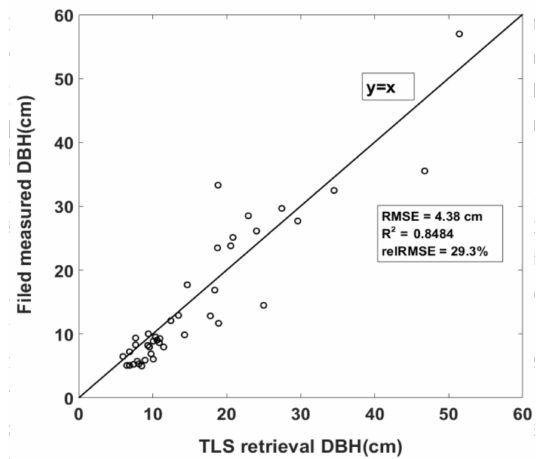
Figure 18. Scatter plot for TLS estimated versus field measured DBH, in the best accuracy condition of single-scan mode of the natural secondary forest (Landau algorithm, a height bin of 1.34 m, and a gray scale threshold of 3).